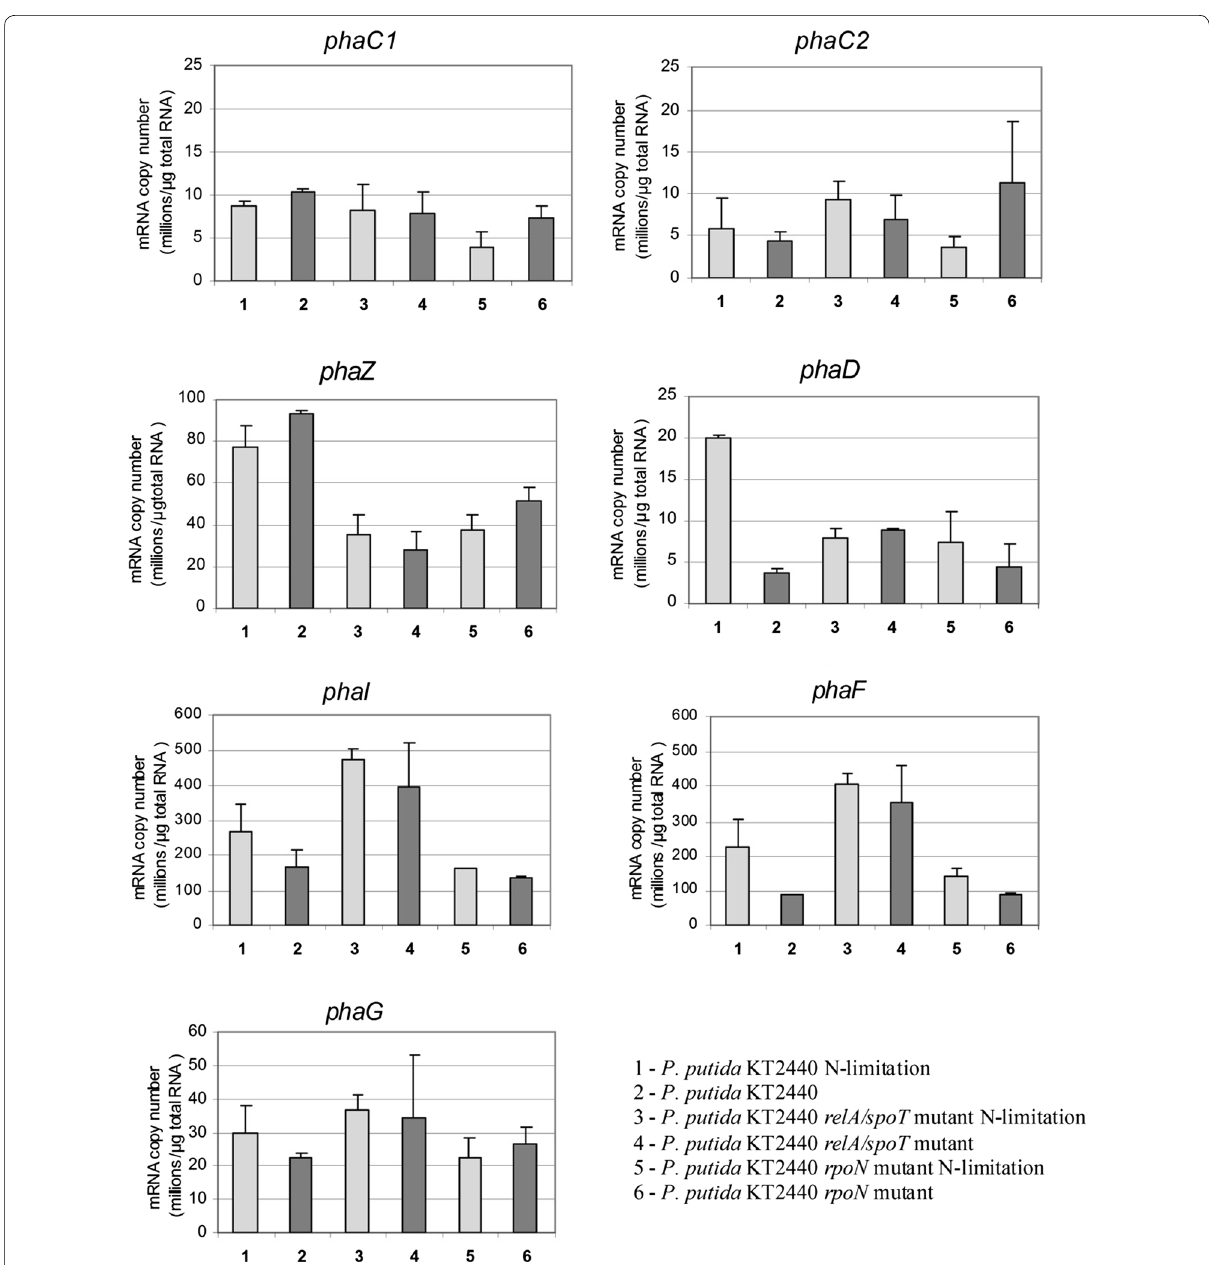
Fig. 3 The result of quantitative real‑time reverse transcription PCR analysis of phaC1 , phaZ , phaC2 , phaD , phaI , phaF , and phaG genes. Samples were taken at 48 h of cultivation. Each data represents the mean